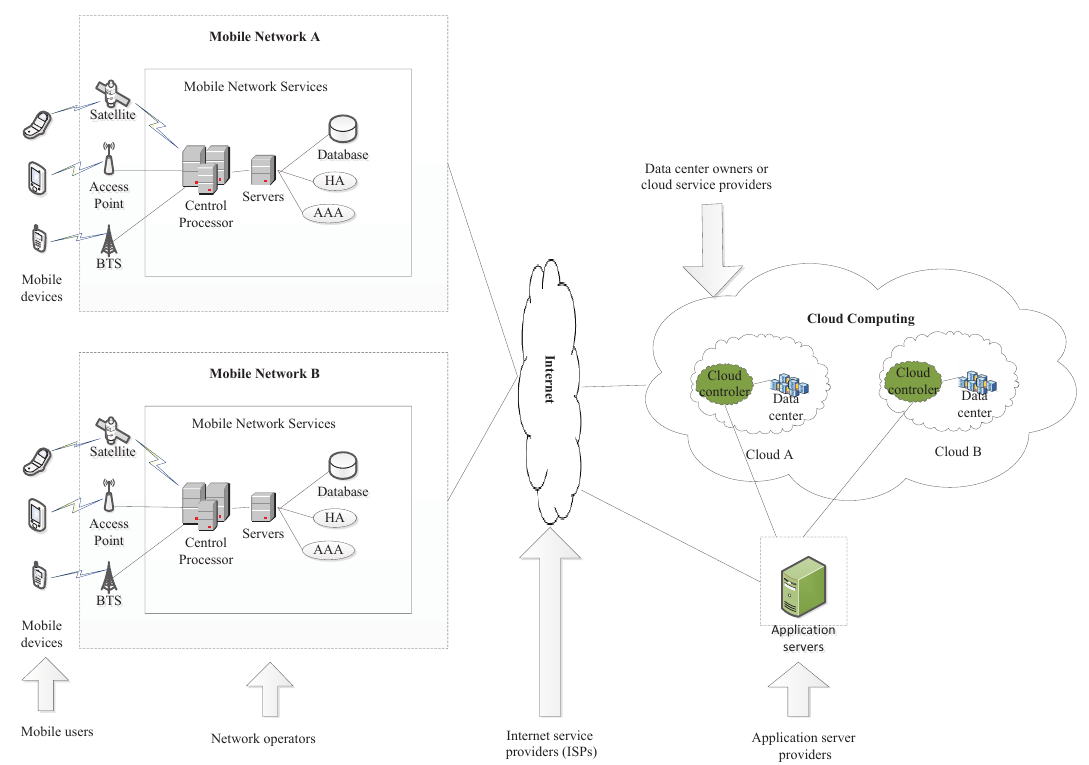
Figure 1. Architecture of Mobile Cloud